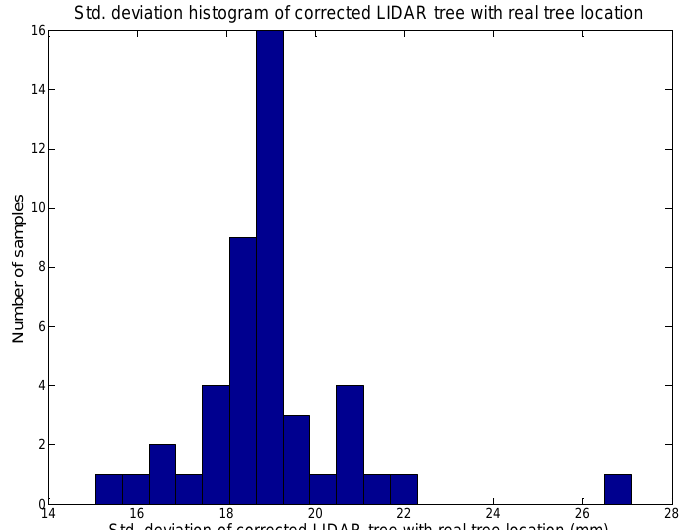
Figure 10. Histogram of the standard deviation error from the LIDAR tree location and real tree